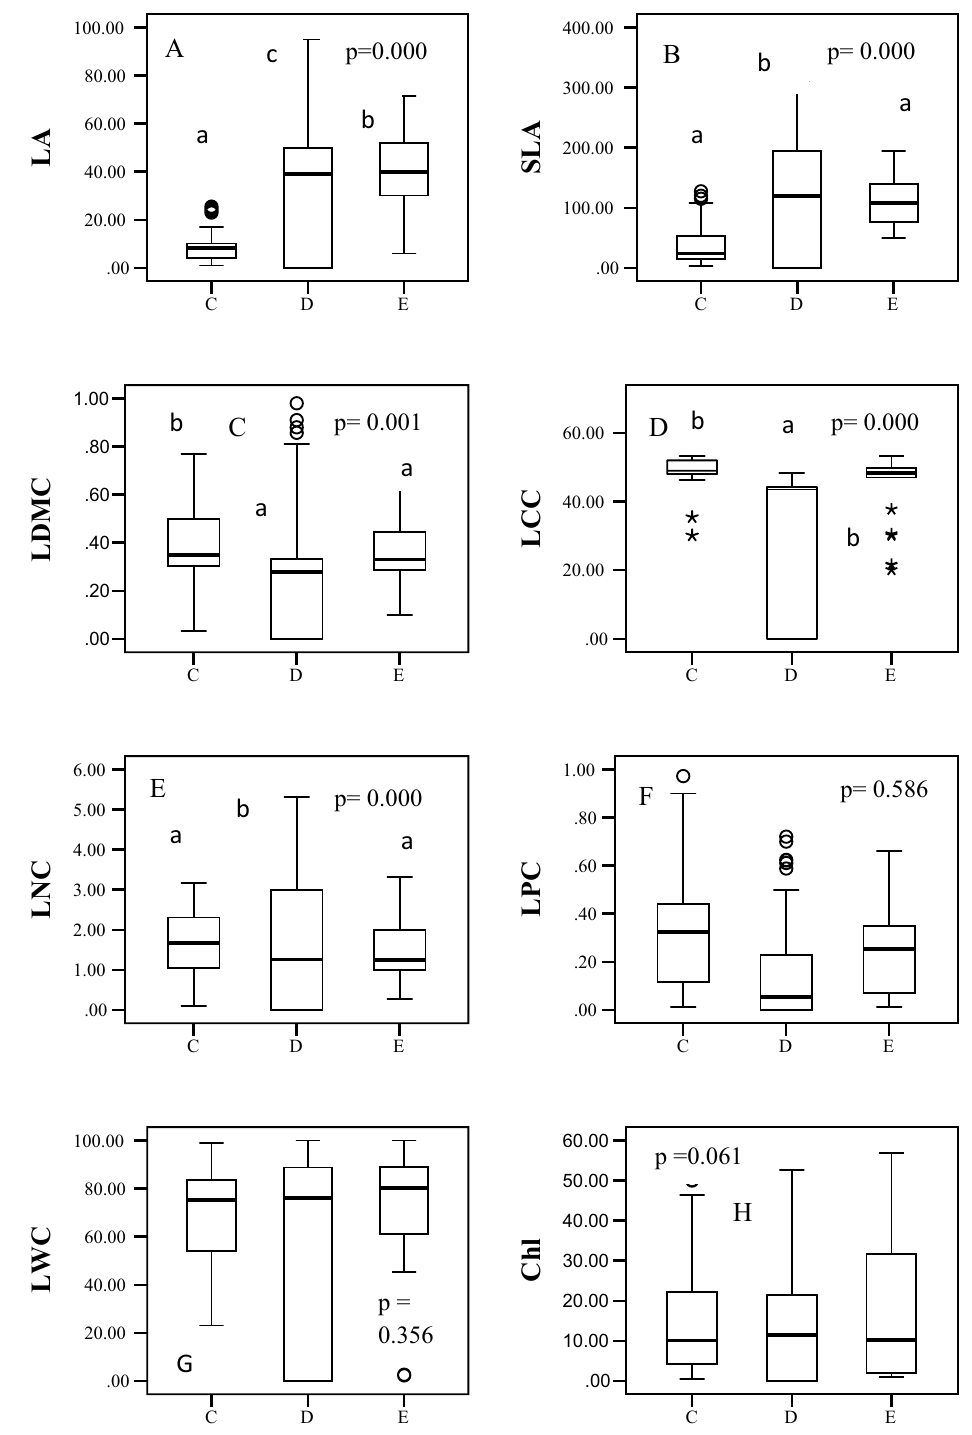
Figure 1. Distribution of values of various traits of tree species of different leaf habits in a temperate forest in Mussoorie Forest Division, Uttarakhand, Indian Himalayas (C = conifers, D = deciduous broad- leaved, E = evergreen broad-leaved): Morphological; LA = leaf area, cm 2 ; SLA = specific leaf area, cm 2 g −1 ; LDMC = leaf dry matter content, %; Chemical; LCC = leaf carbon content, %; LNC = leaf nitrogen content, %; LPC = leaf phosphorus content, %; Physiological; LWC = leaf water content, %; Chl = chlorophyll, mg g −1 ; A = photosynthetic rate, μmol CO 2 m −2 s −1 ; Gs = stomatal conductance, mol H 2 O m −2 s −1 ; E = transpiration rate, mmol H 2 O m −2 s −1 ; Stoichiometry; Leaf C/N and Leaf N/P. The centerline indicates the median, upper and lower box heights indicate interquartile range. The alphabets within the figure represents results of post ANOVA multiple comparison by LSD. Different alphabets represents statistically different